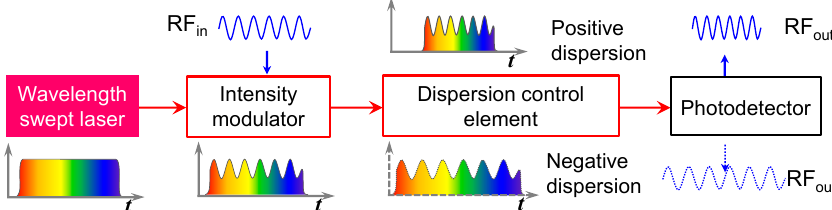
Figure 1. The working principle of the proposed microwave photonic frequency conversion system (the red arrows are the optical path; the blue arrows are the electrical path; the curves with the gradient face color are the optical pulses; the blue curves are the microwave signals; RF in is the input radio frequency signal; RF out is the output radio frequency signal).